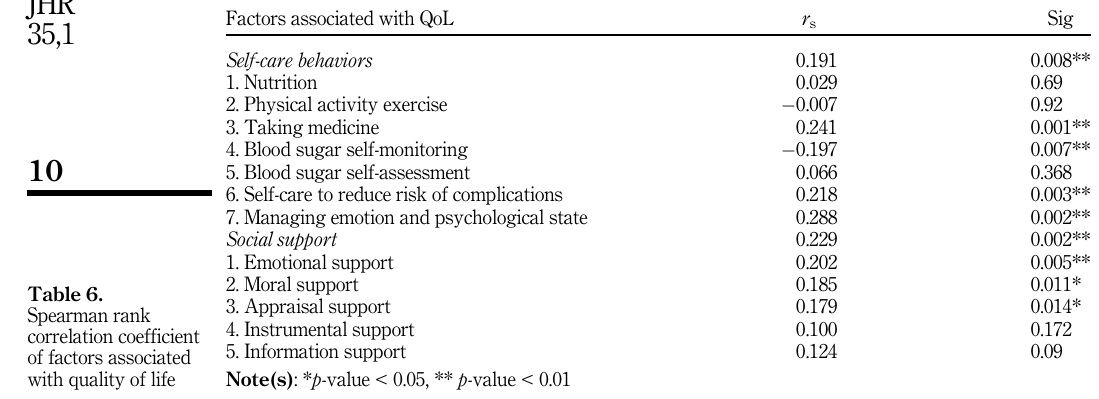
Table 6. Spearman rank correlation coefficient of factors associated with quality of